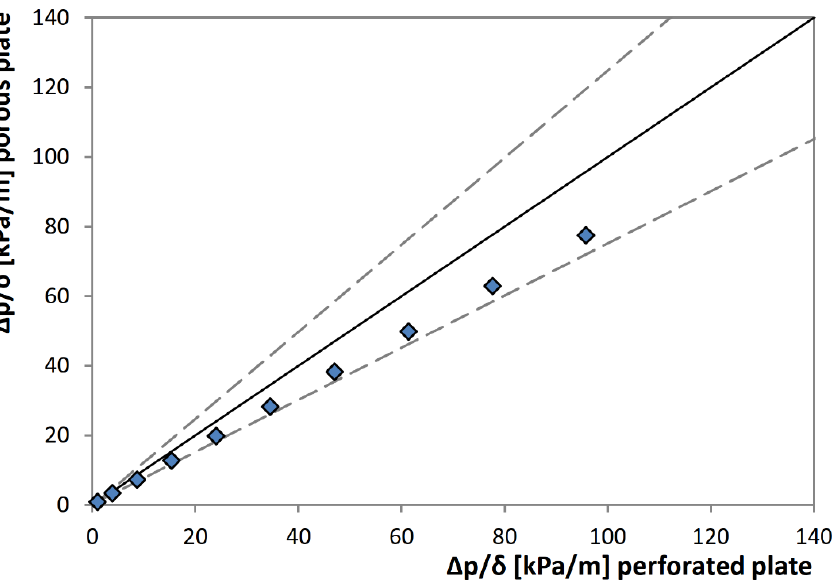
Figure 8. Comparison of pressure drop per depth of the plate for perforated and porous plates, f = 0.40.